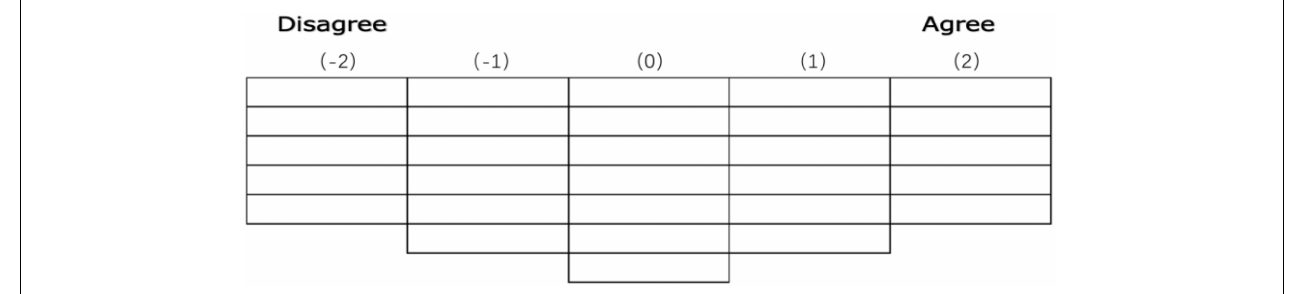
FIGURE 1 | Five-level distribution